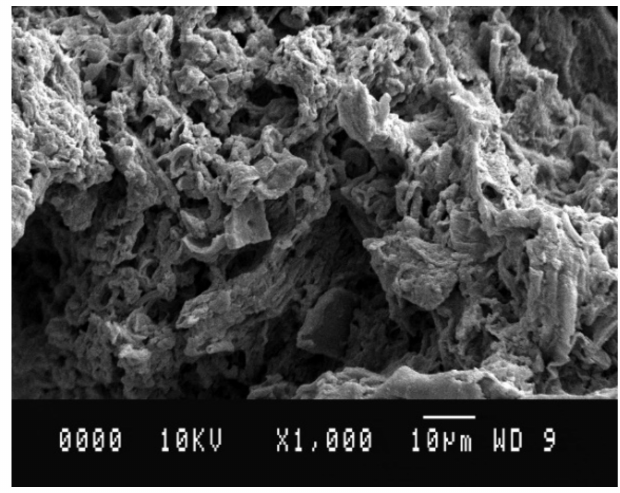
Figure 15. Typical SEM microimages of the Pt studied at a magnification of 1000.